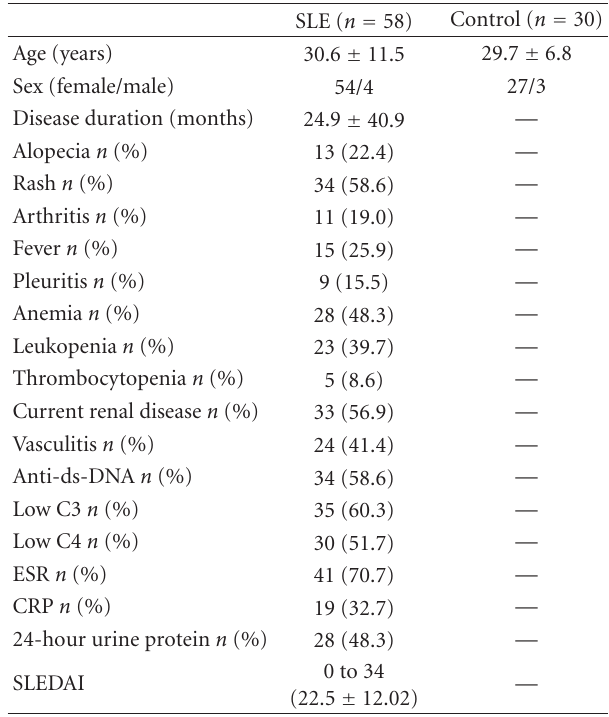
Table 1: Characteristics of SLE patients and the control